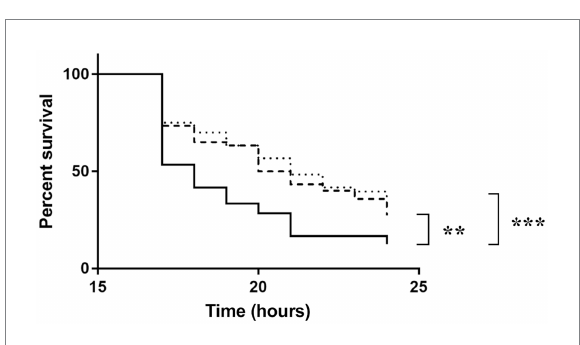
FIGURE 9 Survival of Galleria mellonella larvae infected by Enterococcus faecalis WT (solid line), Δ 5’ nagY (dashed line), or Δ hylA (dotted line) strains. The experiment was performed three times using 15 caterpillars per strain and per test. **value of p < 0.01 comparatively to the V19 strain. ***value of p < 0.001 comparing to the V19 strain (log-rank